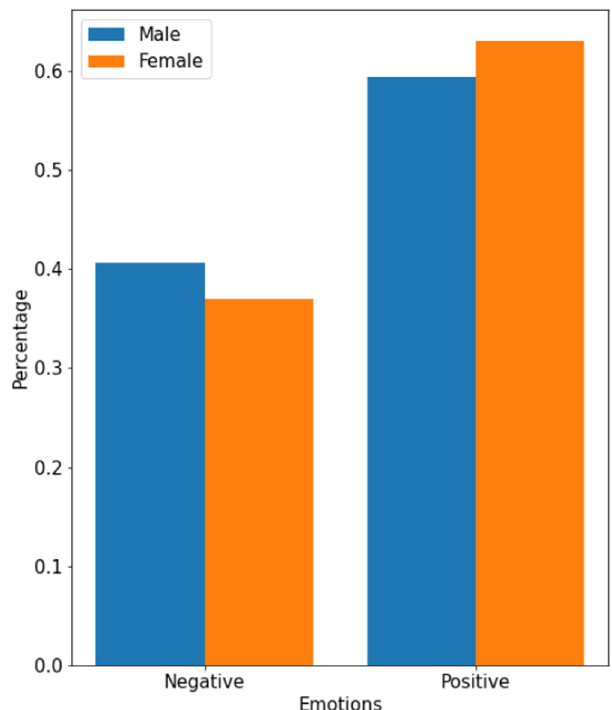
Fig. 4 Gender-wise distribution of emotion scores. Bar graph showing the distribution of positive and negative emotion scores obtained after sentiment